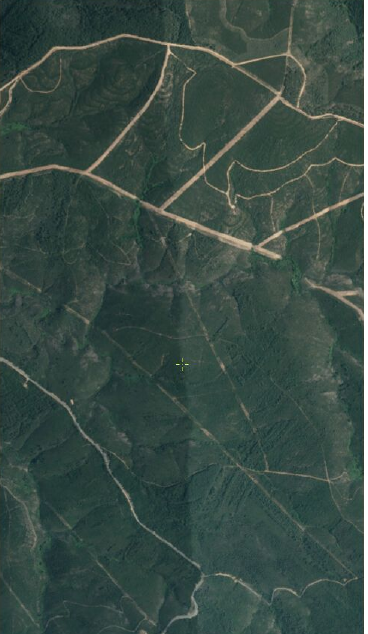
Figure 5: Original orthophoto mosaic (part 2)